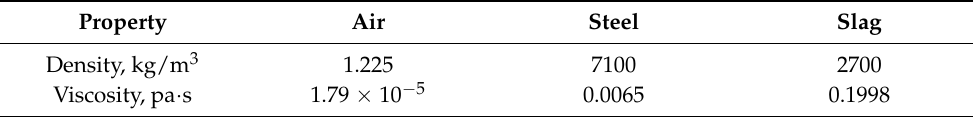
Table 1. Physical parameters of fluid used in simulation.